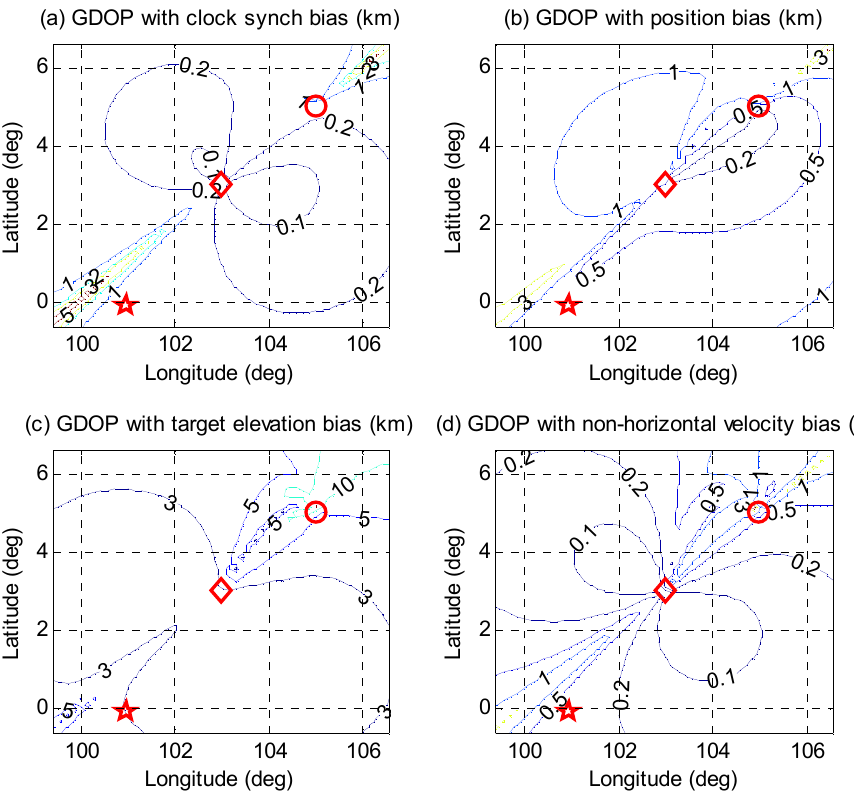
Figure 7. GDOPsofpositionestimationforthescenarioofusingLEOsatellite, airplaneandground Figure 7. GDOPs of position estimation for the scenario of using LEO satellite, airplane and ground station.